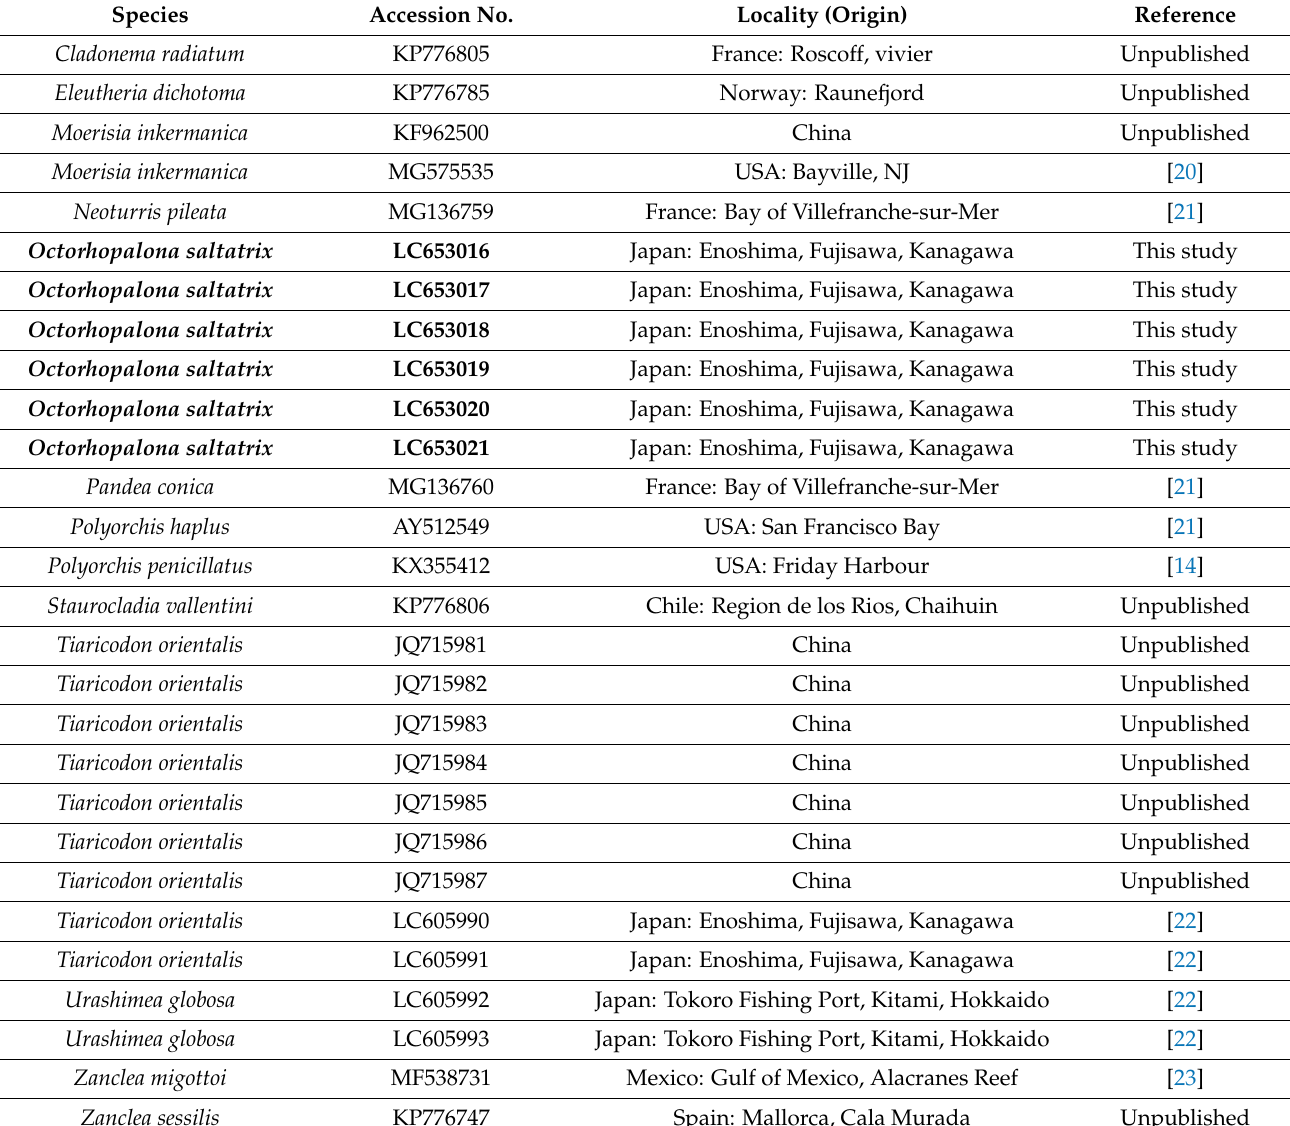
Table 1. Taxa included in the phylogenetic analyses and GenBank accession numbers for the 16S rDNA sequences. Sequences obtained in this study are in